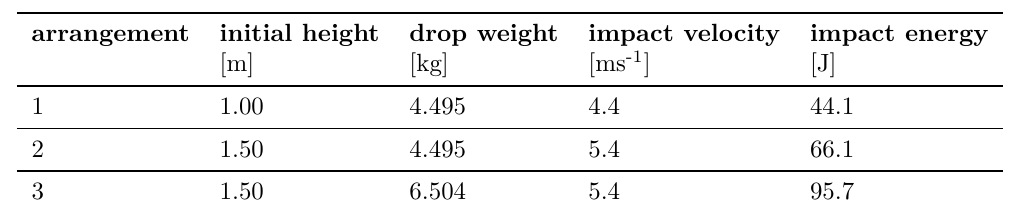
Table 1. Impact test parameters.